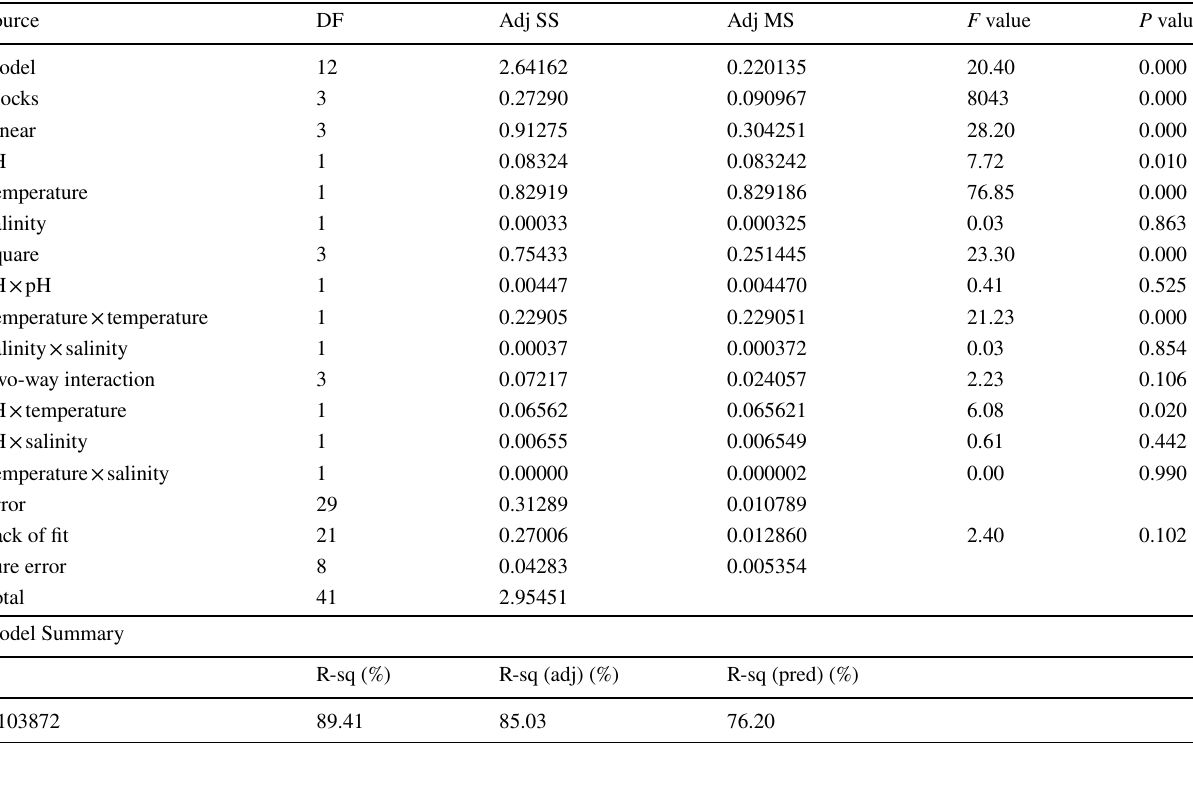
Table 4 Analysis of variance (ANOVA) of Box–Behnken design of experiment showing response-surface regression of Ei versus blocks, pH, temperature, and